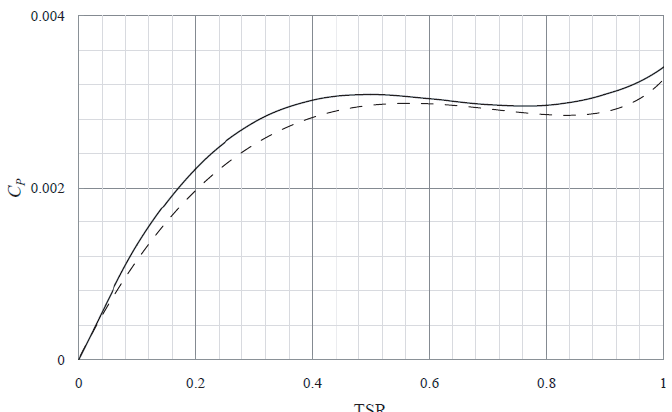
Figure 32. Coefficient of power as a function of TSR for three-bladed